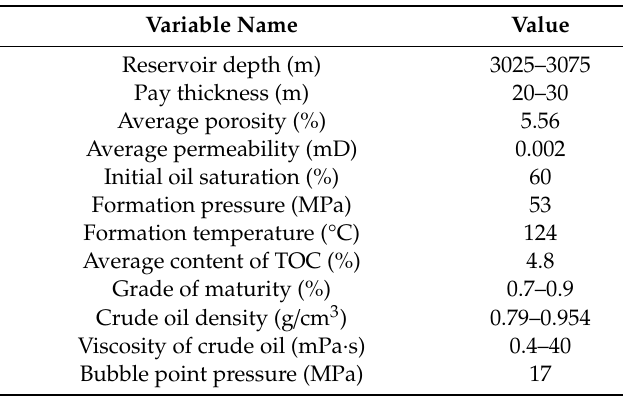
Table 1. Reservoir properties.